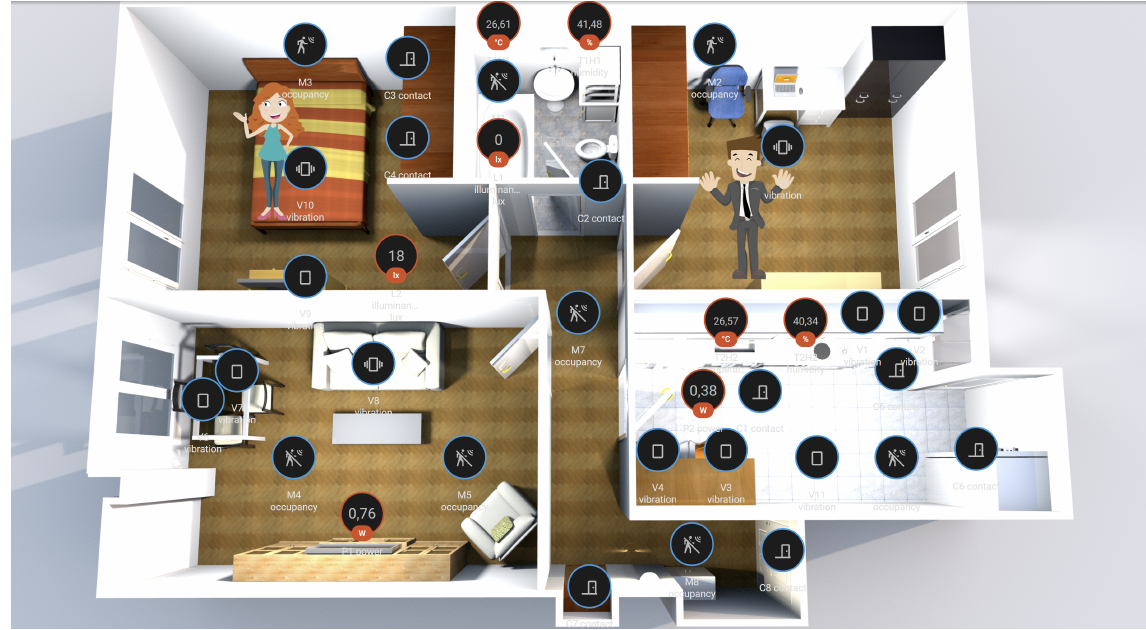
Figure 2. Visual interface provided by the Home Assistant operating system.